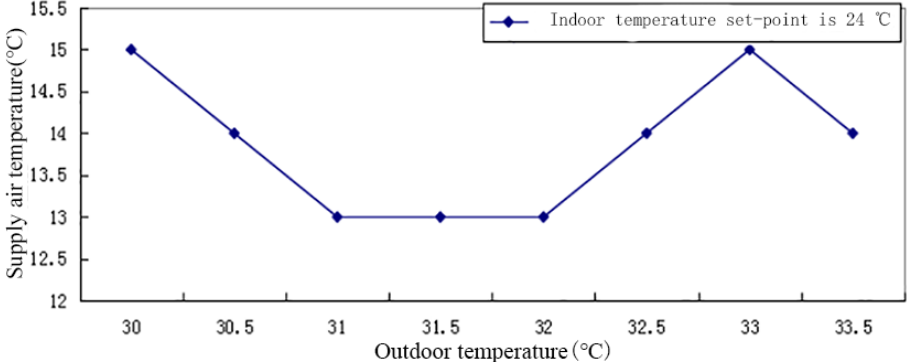
Figure 12. Optimal supply air temperature when indoor temperature set-point is 24 °C.